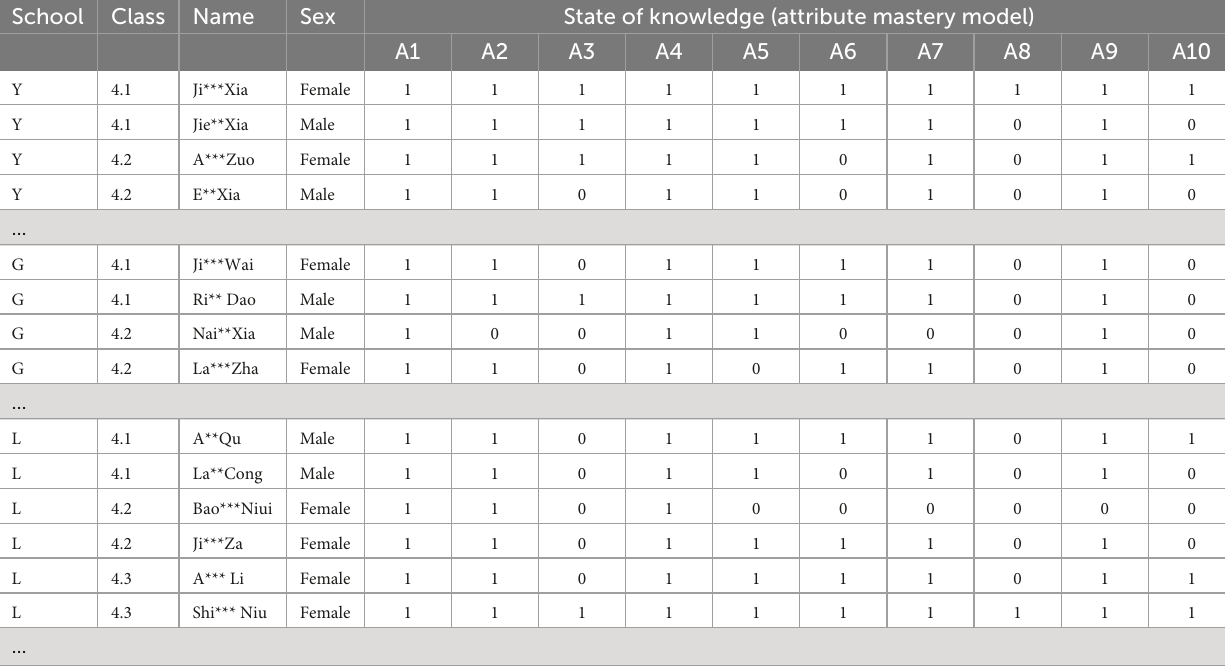
TABLE 5 A total of 4th-grade Yi students’ mathematical skills and cognitive diagnostic knowledge state. School